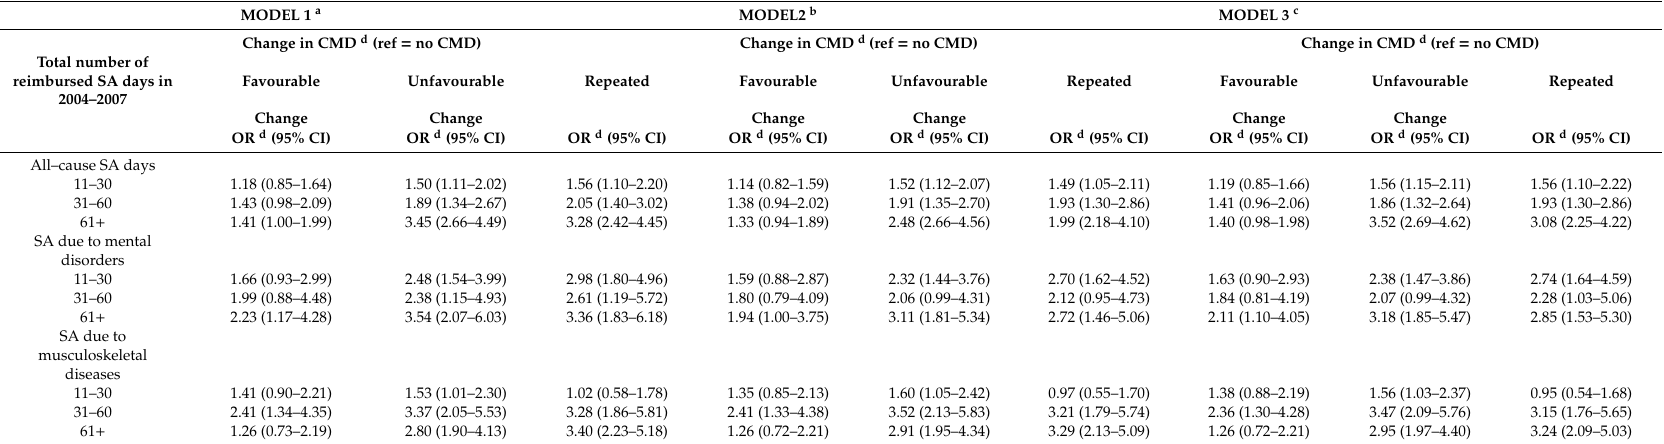
shift work, physical strenuousness of work, job strain. d Favourable change = CMD in 2007 only, unfavourable change = CMD in 2012 only, repeated CMD = CMD in both 2007 and